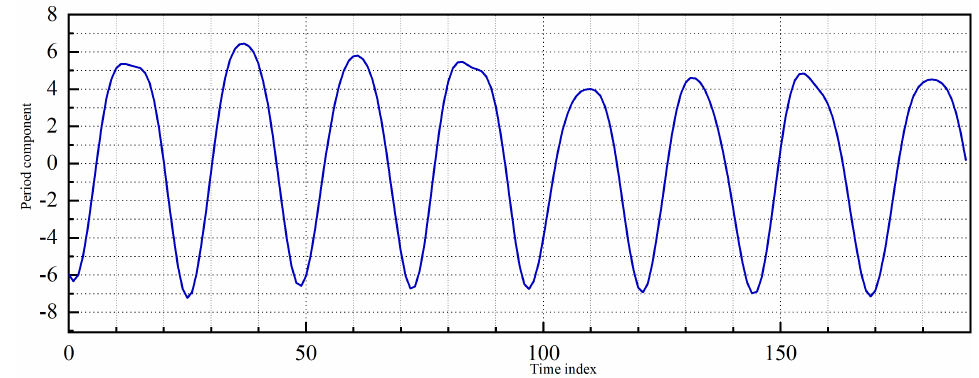
Figure 10. Period component.